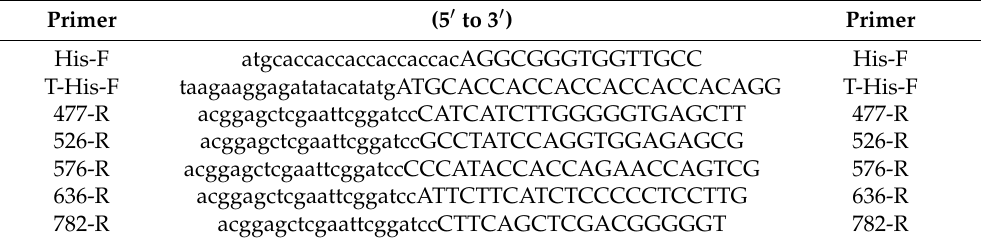
Table 5. Primers used in the